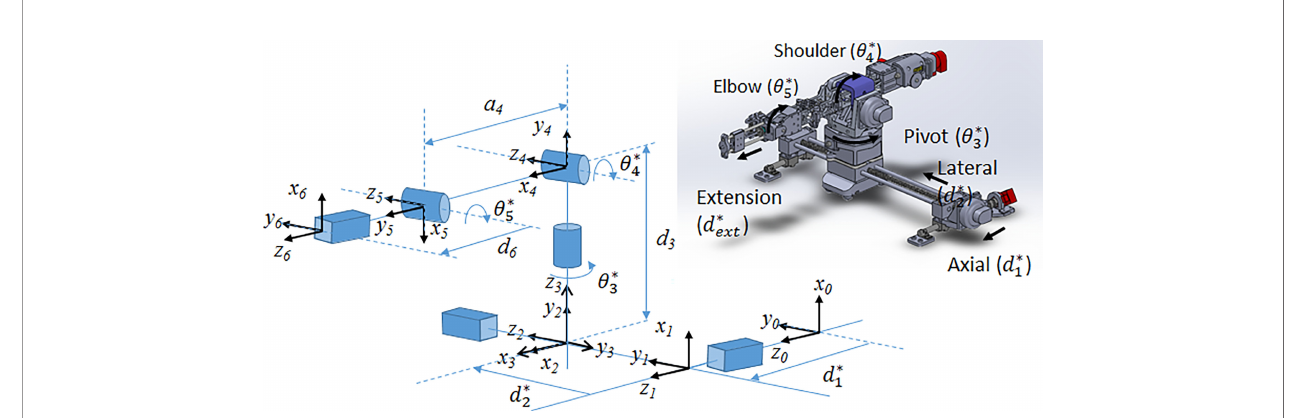
FIGURE 1 | (Left) Joint-level schematic of robot showing coordinate systems and movement of each joint; (right) CAD rendering of the 6-DOF robot showing joint